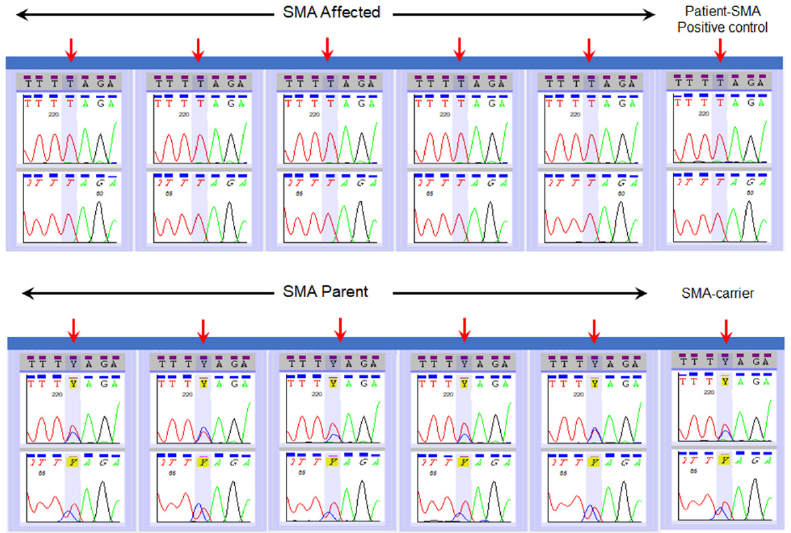
Figure 2. Typical examples of SMA sequencing assay on reference samples from SMA affected patients and their parents.